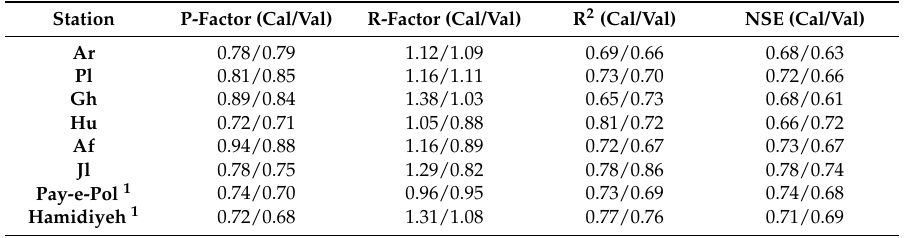
Table 3. Statistical measures for monthly outflows at the eight stations for calibration and validation periods.